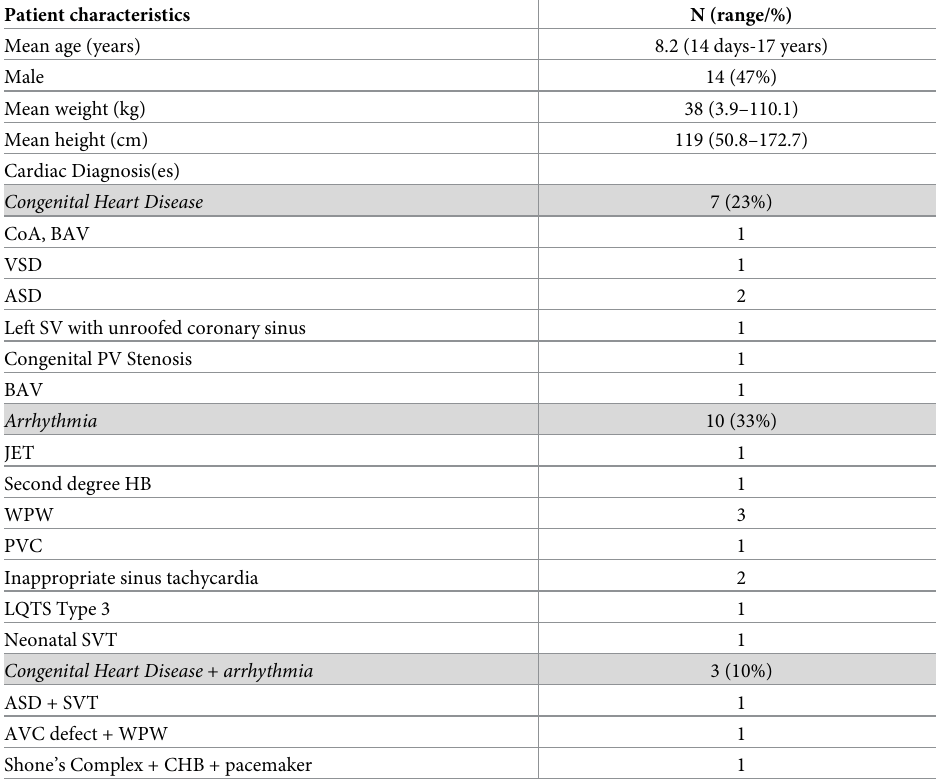
Table 1. Demographic data. Patient demographic data is shown with descriptive statistical data. Abbreviations: CoA = coarctation of the aorta, BAV = bicuspid aortic valve, VSD = ventricular septal defect, ASD = atrial septal